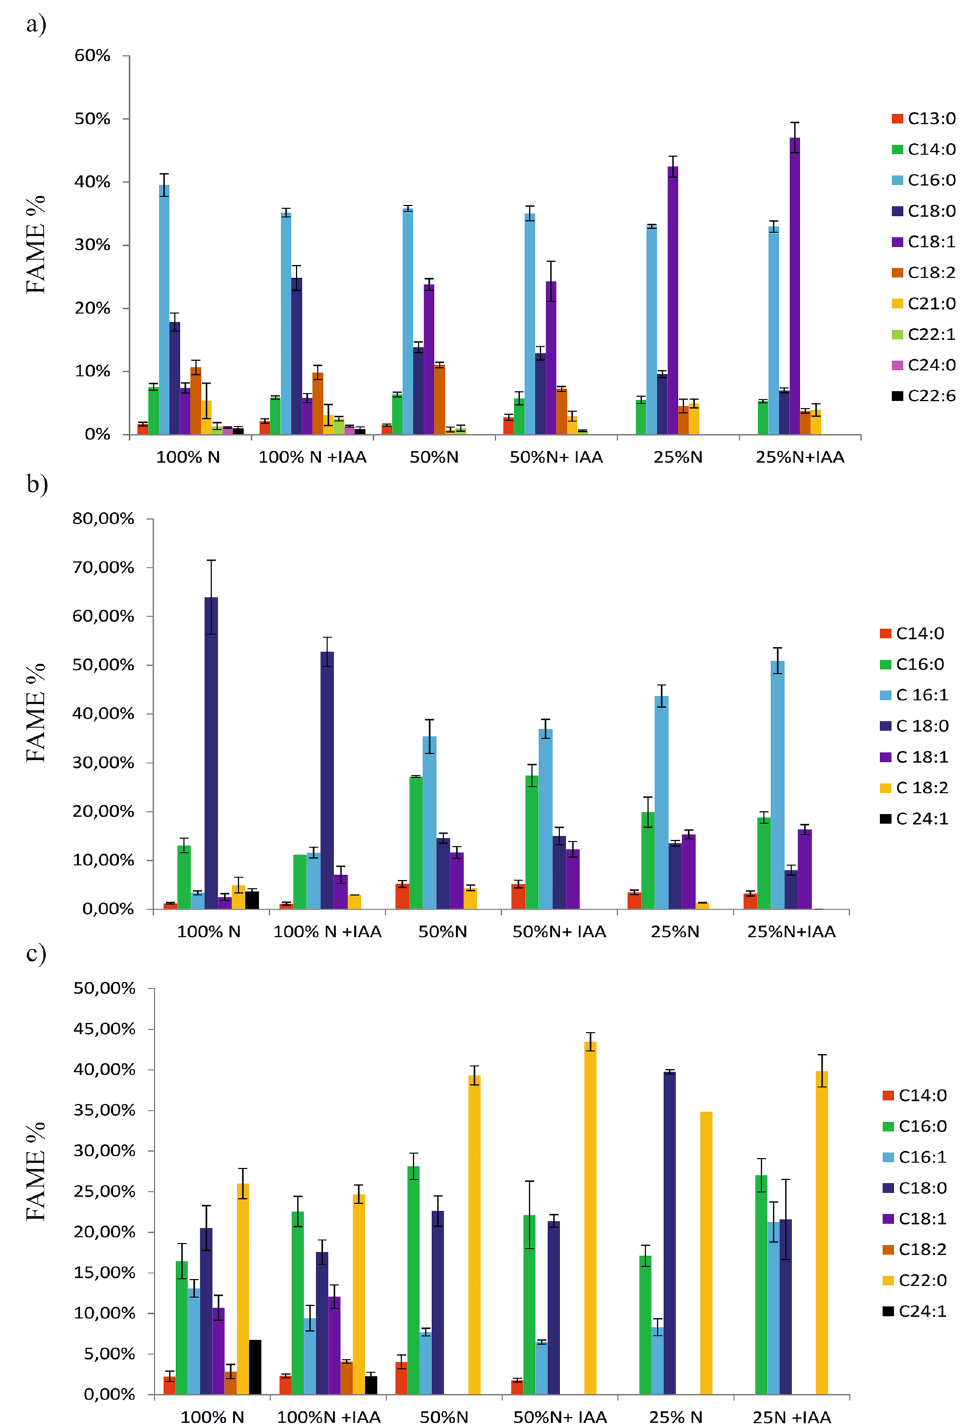
Figure 5. Effects of culture conditions on the fatty acid profile of Eustigmatos calaminaris ( a ) neutral lipids, ( b ) glycolipids, ( c ) phospholipids. Data are expressed as means (± SD), n =